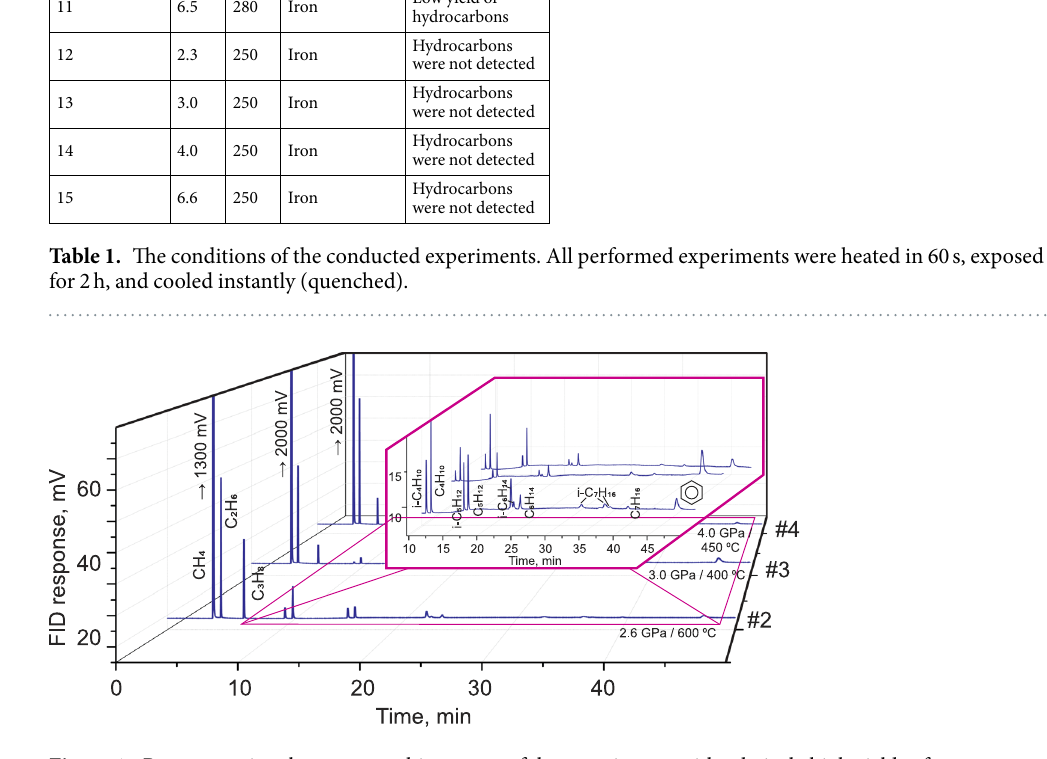
Figure 1. Representative chromatographic spectra of the experiments with relatively high yields of gaseous